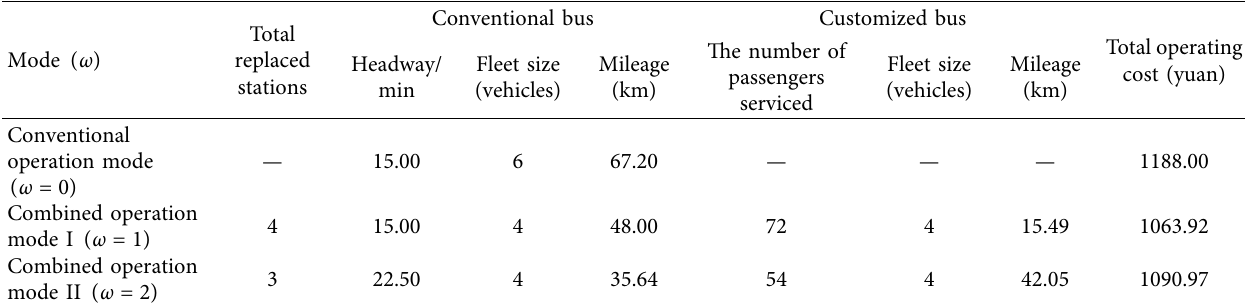
Table 3: The optimal bus operation plans in different modes (travel demand � 200 passengers per